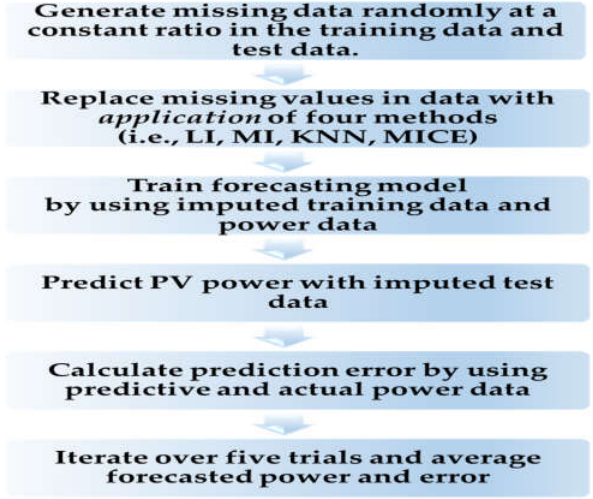
Figure 4. Process of the simulation for PV forecasting model.